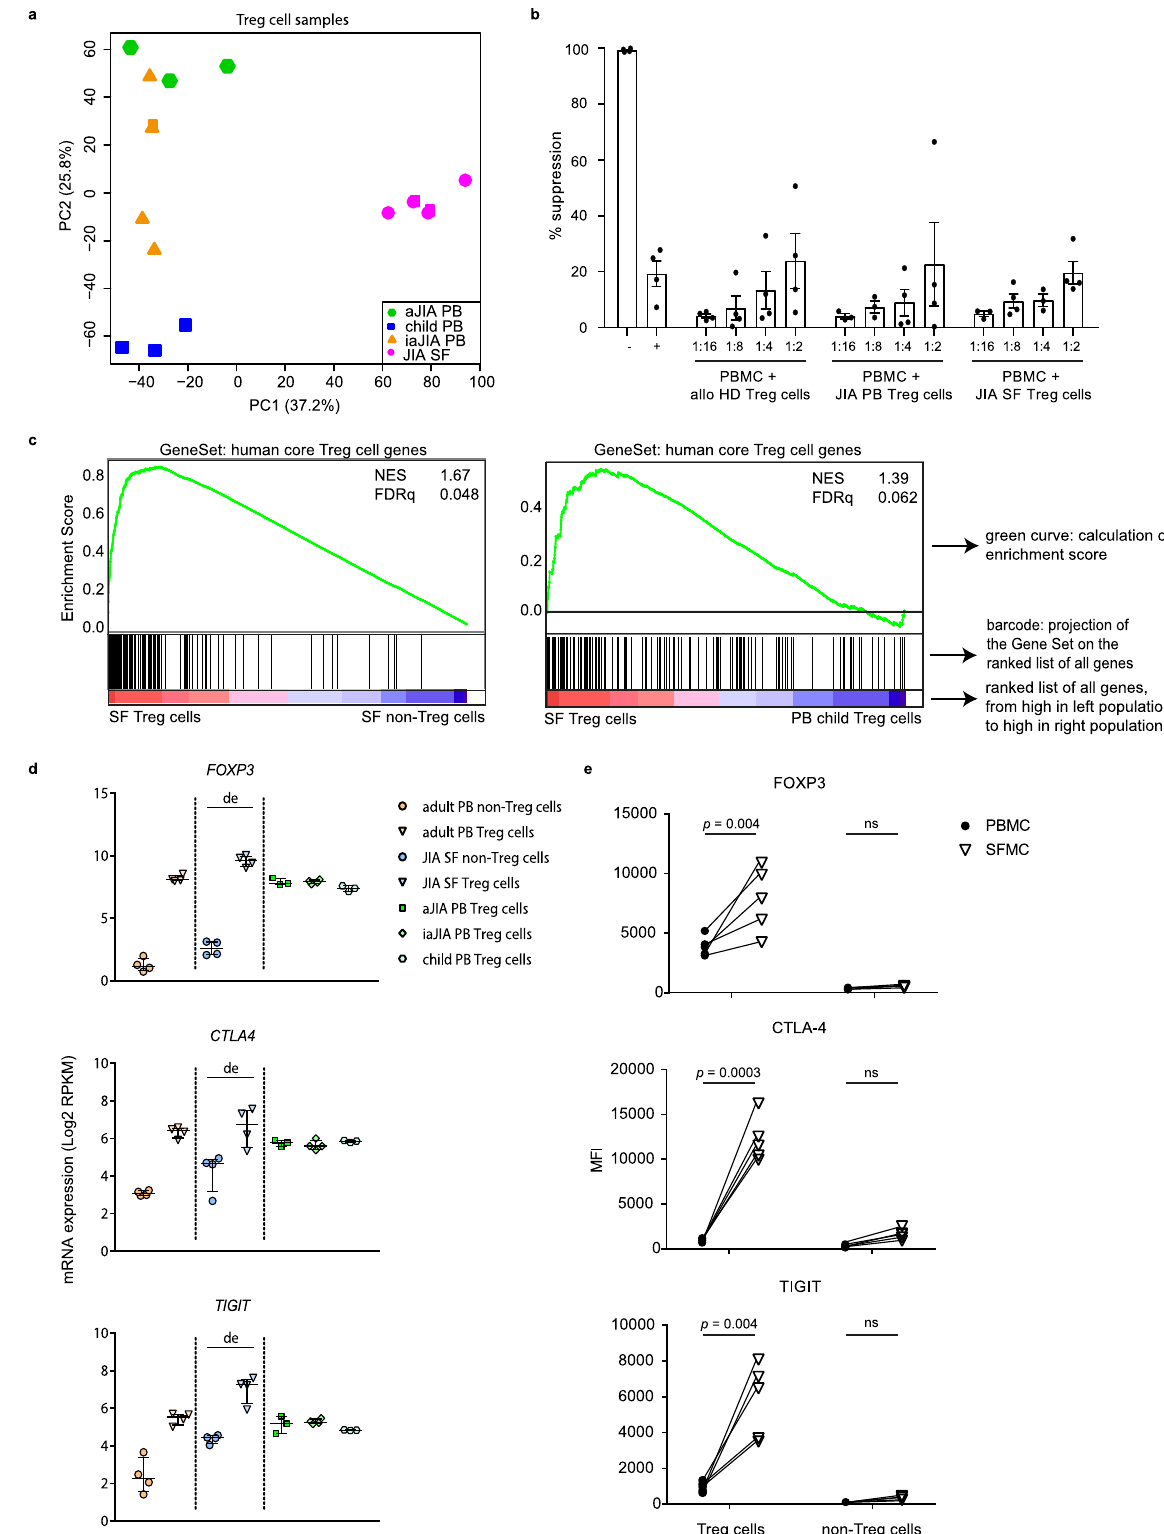
including pathways linked to cytokine responses such as Inter- feron and IL-12 (Supplementary Fig. 4a). K-mean, and sub- sequent gene ontology analysis of SF Treg cells and all PB Treg cell groups derived from children demonstrated that pathways associated with Th1-skewing were speci fi cally upregulated in SF Treg cells (Fig. 3b and Supplementary Fig. 4b, c).